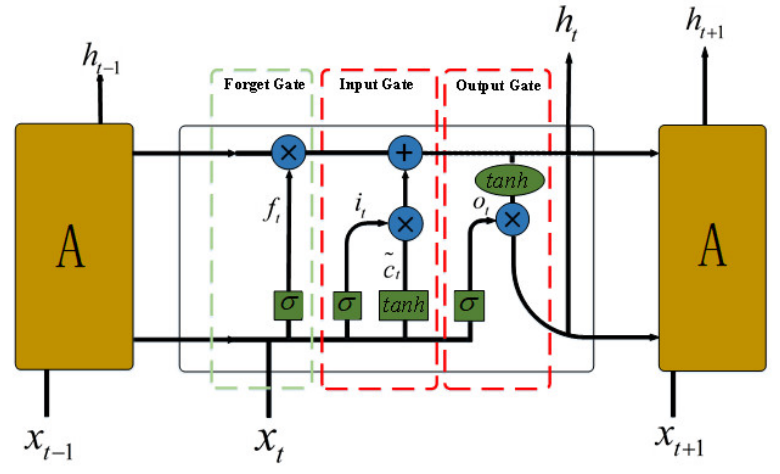
7 of 18 Figure 5. Schematic diagram of residual block. 2.3.2. Force Estimation A Recurrent Neural Network (RNN) is a computational model designed to deal with the temporal features of the input signal. It is quite similar to a feed–forward neural net-